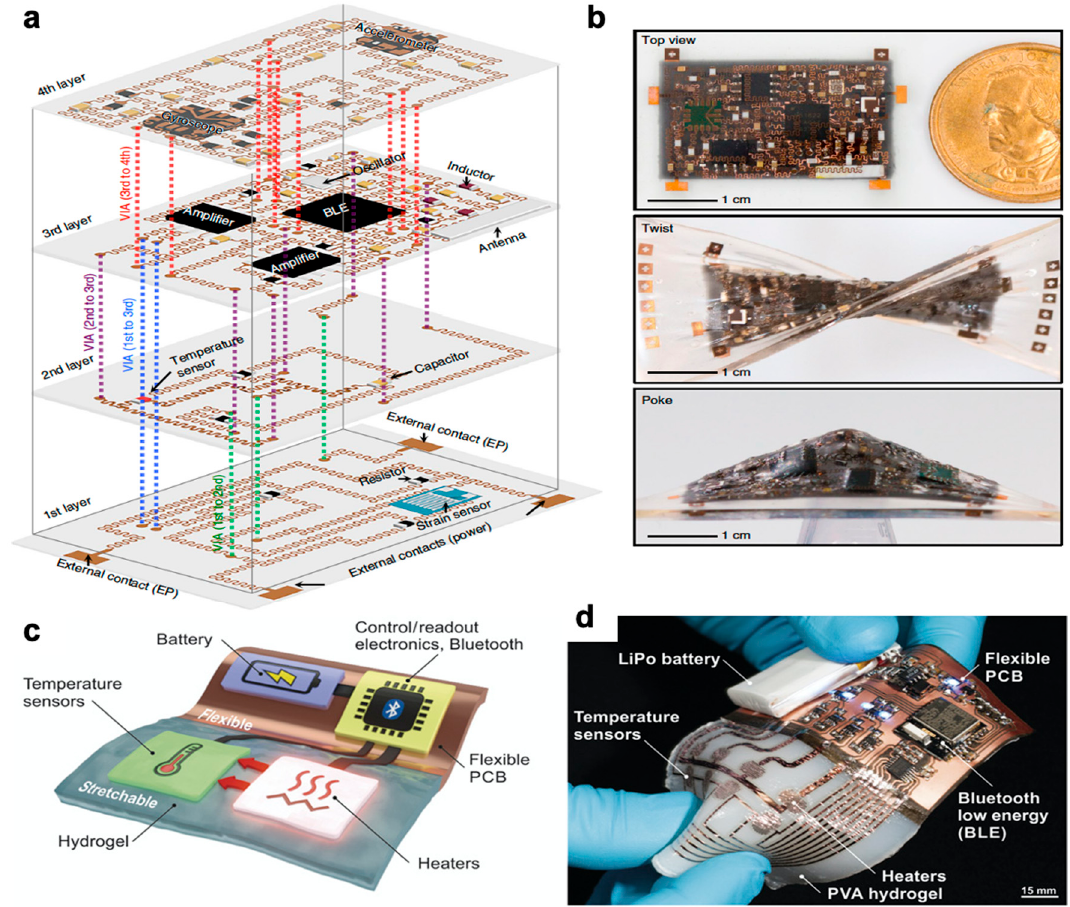
Figure 23. ( a ) Exploded schematic of a four-layer electronic system and ( b ) demonstration of the system’s ability to withstand mechanical deformation. Reproduced with permission from [24].